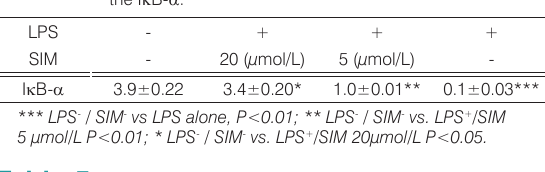
Table 5. The PDTC and siTLR4 inhibit the LPS-induced TNF- a and iNOS expression.